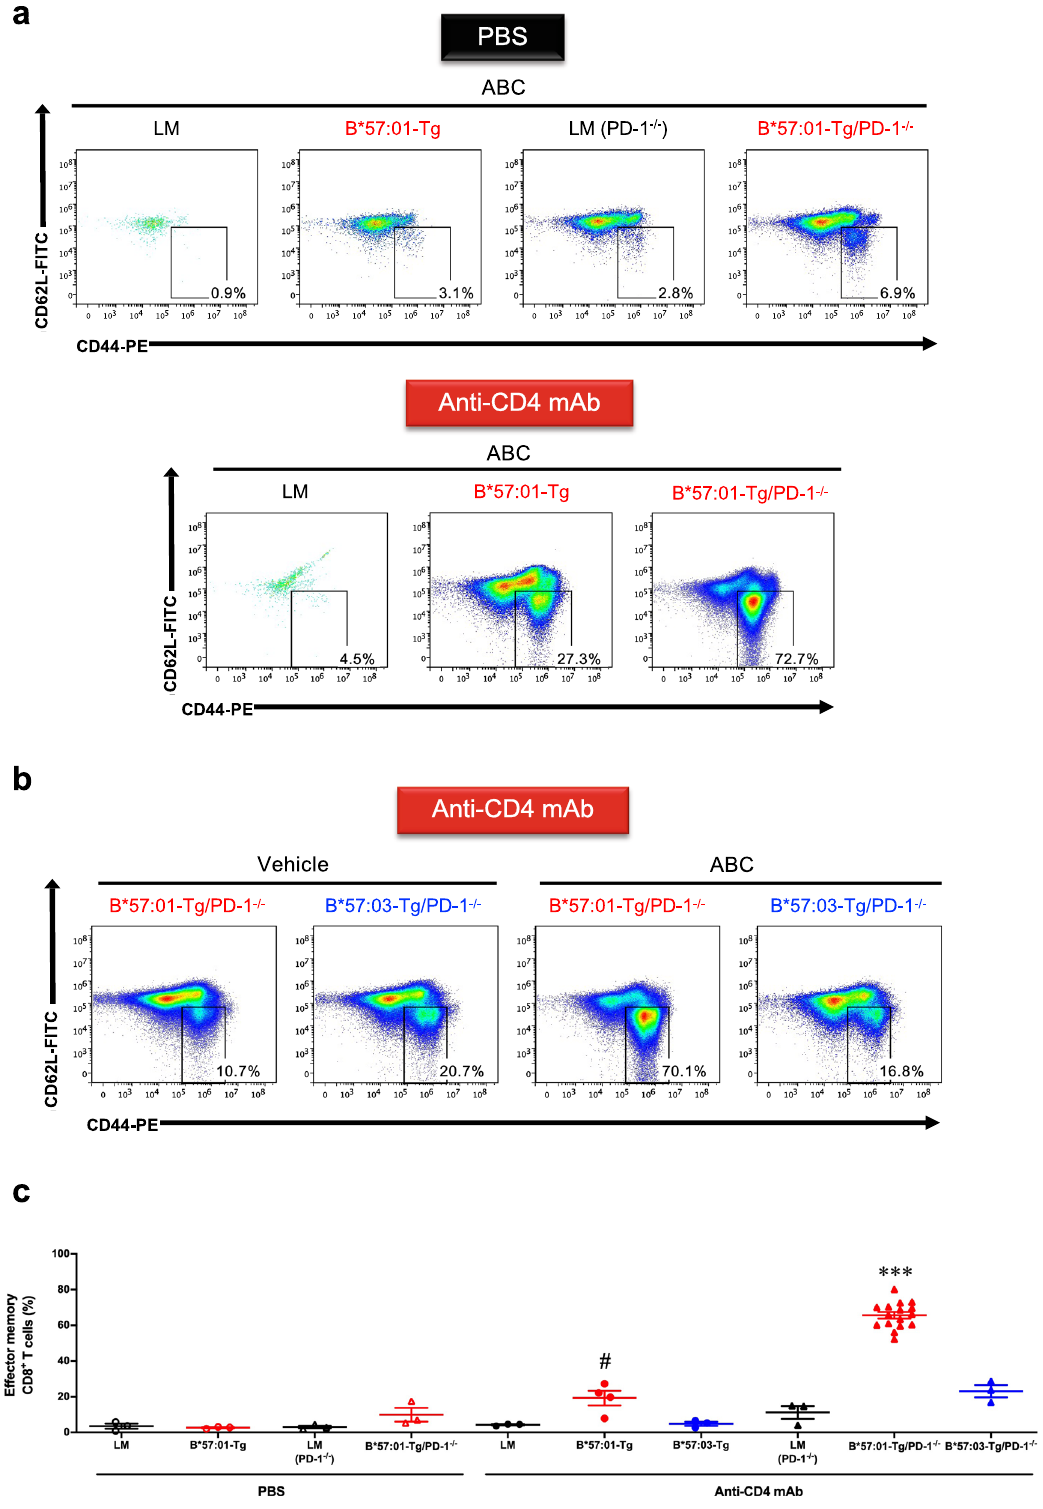
Fig. 3 Effect of PD-1 knockout on abacavir (ABC)-induced activation of T cells in CD4 + T cell-depleted HLA-B*57:01 transgenic (Tg) mice. a and b Representative dot plots depicting effector memory T cells in gated CD8 + T cells, classi fi ed by the phenotype of CD44 and CD62L expression in the auricular lymph node (LN) from PBS-treated or CD4 + T cell-depleted mice. Each group was orally administrated 1% (w/w) ABC or a normal diet (vehicle) for 1 week. Effector memory T cells: CD44 high CD62L low . Data are representative of three independent experiments. c Percentages of effector memory T cells among CD8 + T cells isolated from the auricular LN of 1% (w/w) ABC-fed mice. Each plot represents an individual mouse with the mean ± SEM ( N = 3 – 16); *** p < 0.001, compared with other mice groups; # p < 0.05, compared with CD4 + T cell-depleted B*57:03-Tg mice or littermates (LMs), one- way ANOVA with Bonferroni ’ s multiple comparisons correction. Data are a summary of three independent experiments (except the CD4 + T cell-depleted B*57:01-Tg/PD-1 − / − mice, serving as the positive control for each independent experiment). COMMUNICATIONS BIOLOGY| (2021) 4:1137 |https://doi.org/10.1038/s42003-021-02657-2|www.nature.com/commsbio